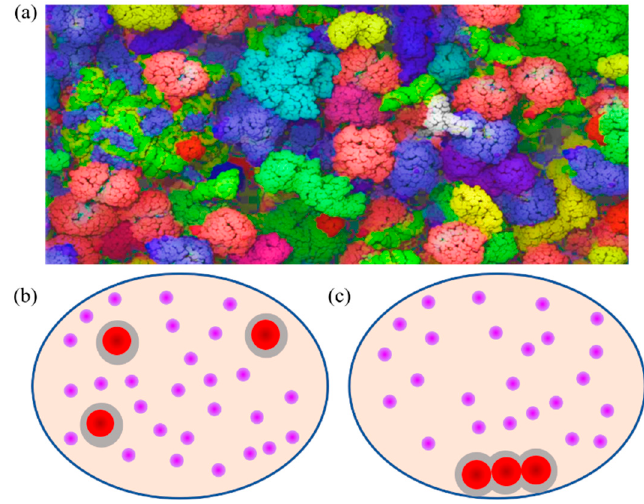
Figure 1. ( a ) Rendering of the E. coli cytoplasm model, in which different-colored shapes represent different macromolecules, including GFP, tRNA, etc. Reprinted with permission from Ref. [7]. 2010, McGuffee, Elcock. Crowding effect illustration in a cell-like structure containing large red spheres and small purple spheres before crowding ( b ) and after crowding ( c ).